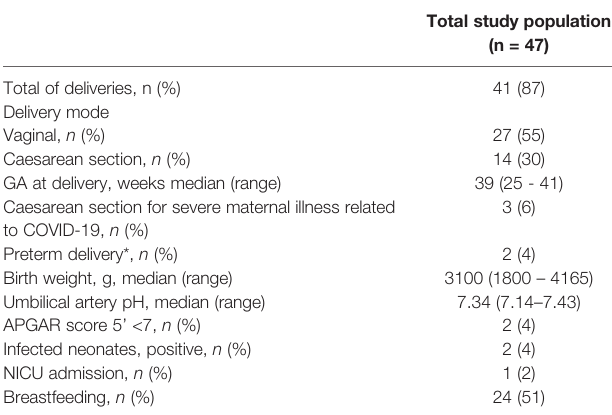
TABLE 2 | Maternal and pregnancy outcomes in the study